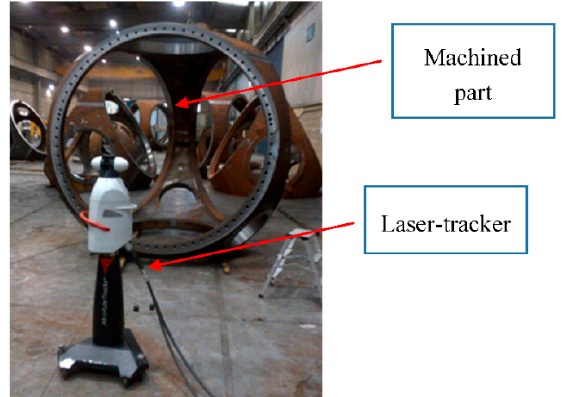
Figure 2. Laser-tracker technology for machined part dimensional inspection.